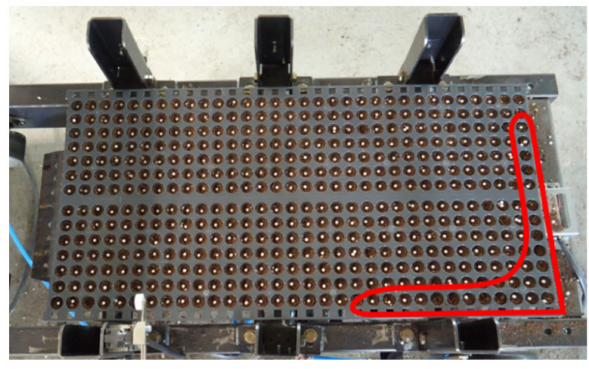
Figure 15. Empty cells of pot tray by seed bounce from inappropriate operating condition.